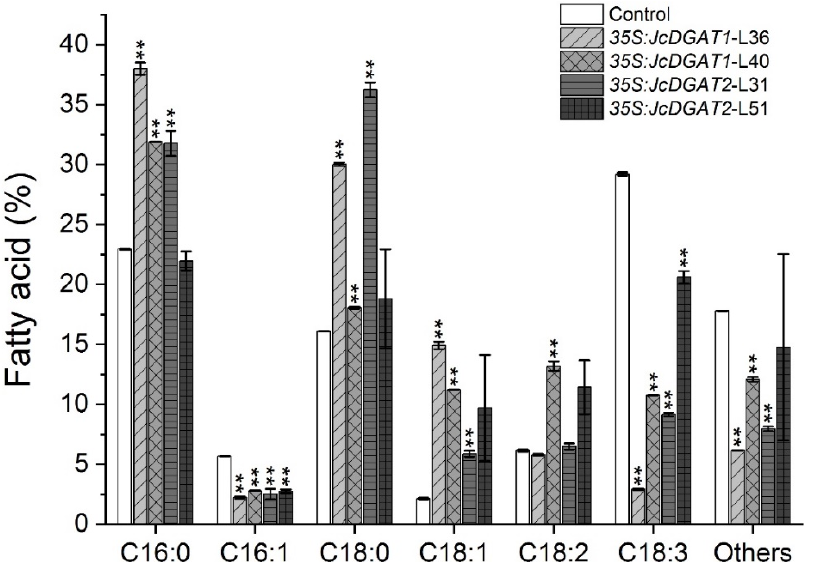
Figure 6. FA profile of TAGs in the leaves of control and transgenic plants. The values are presented as the mean ± standard deviation of two biological replicates. The student’s t -test was used for statistical analyses. ** p ≤ 0.01.